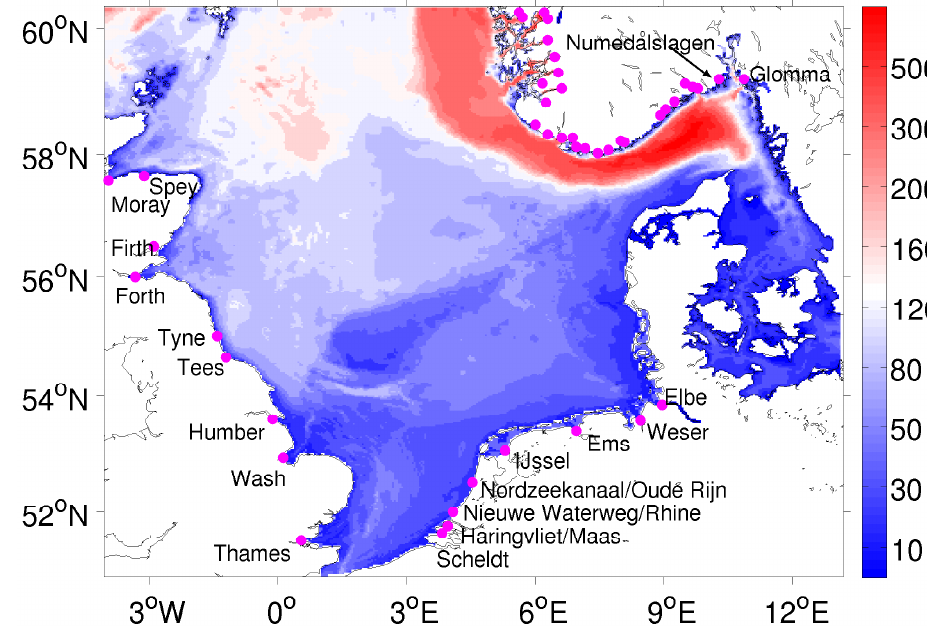
Figure 1. The model domain with topography (metres). River sources of freshwater are shown by magenta